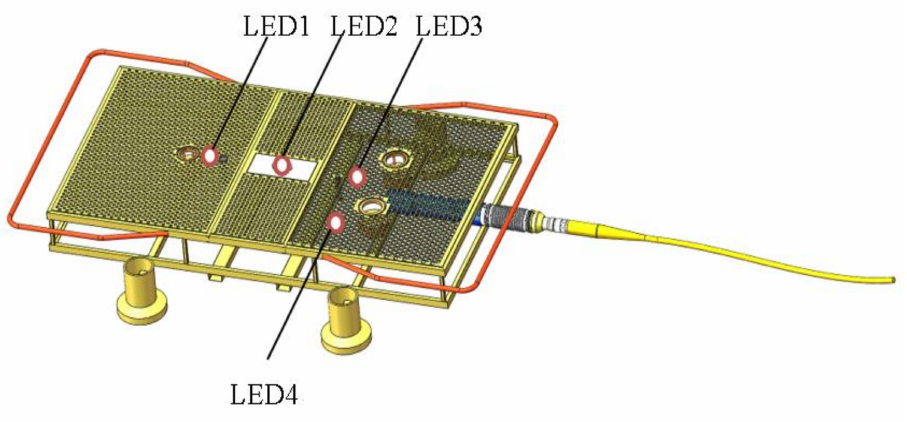
Figure 3. Arrangement of the LED light array on the Docking